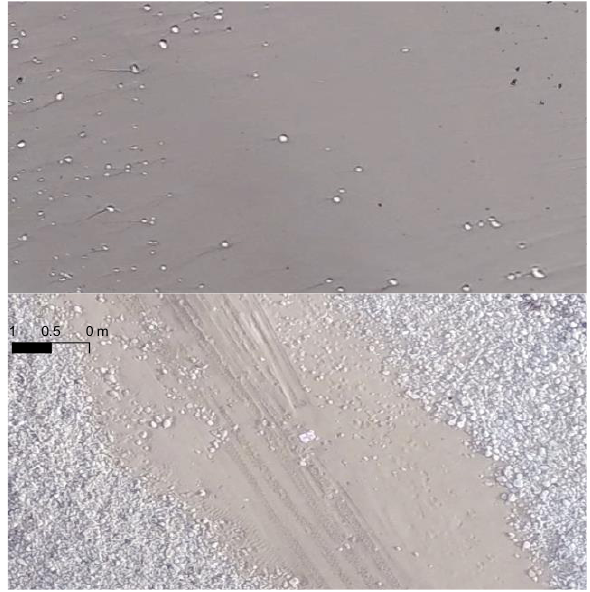
Figure 5: Comparison between the January mission (top picture), and the April mission (bottom picture) on the Beach of “Les Huttes” (same area extracted from each ortho- photography).